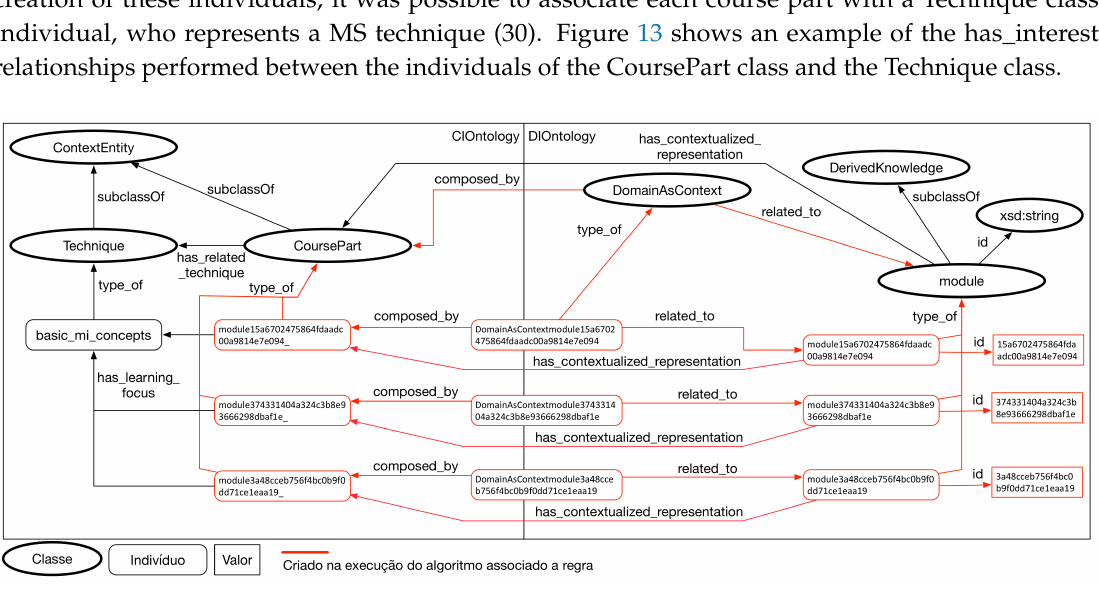
Figure 13. Relationships between individuals in the CoursePart and Technique